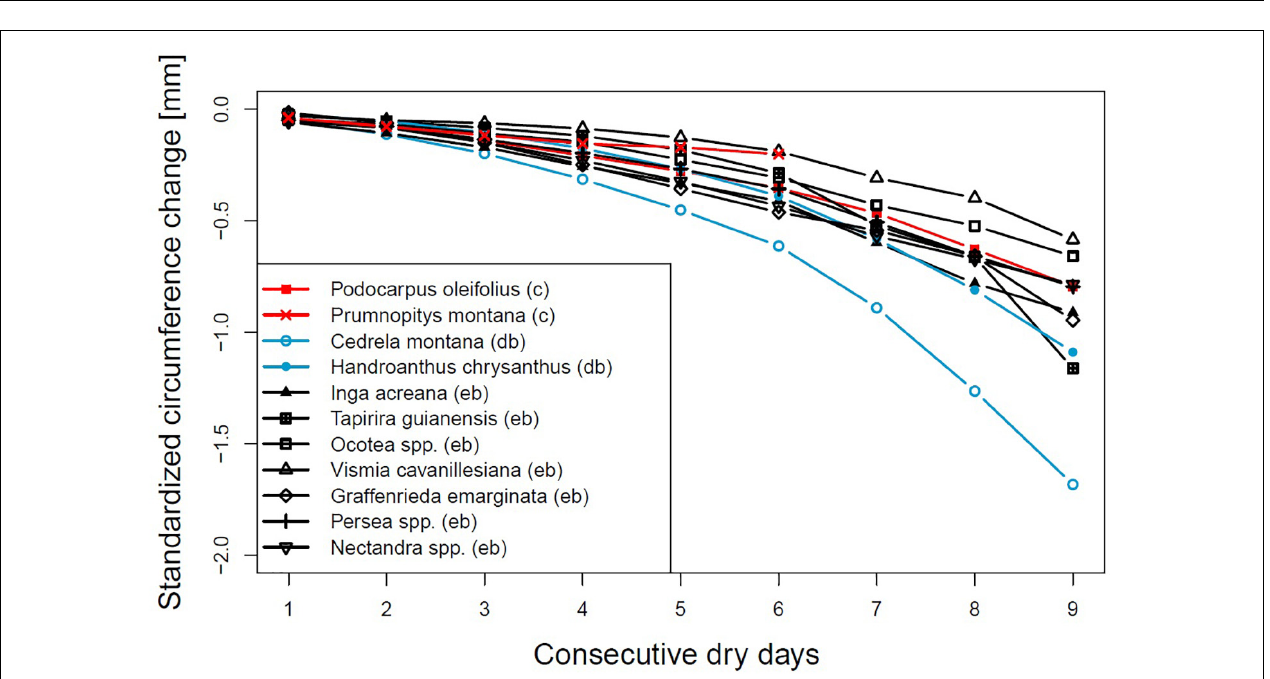
FIGURE 3 | Standardized circumference changes after consecutive rainless days for different genera or species. Evergreen broadleaved (eb, black), coniferous (c, red) or deciduous broadleaved (db, lightblue).